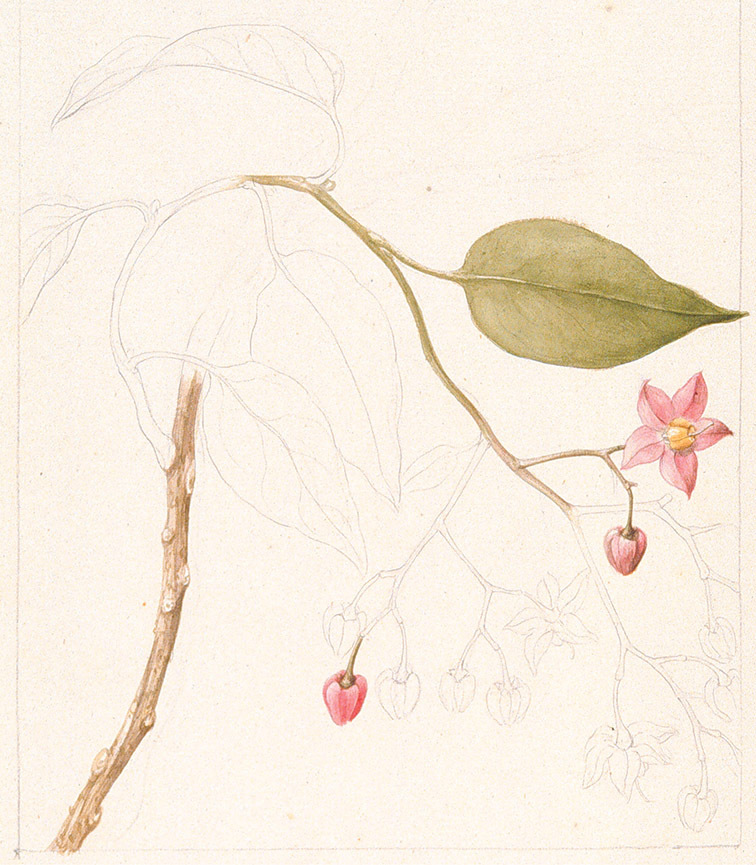
Lectotype of Solanum dulcamaroides Poir. (Torner Collection plate 6331.1503). Reproduced with permission of the Hunt Institute for Botanical Documentation, Carnegie Mellon University, Pittsburgh, PA. Torner Collection of Sessé and Mociño Biological Illustrations. Rights reserved.